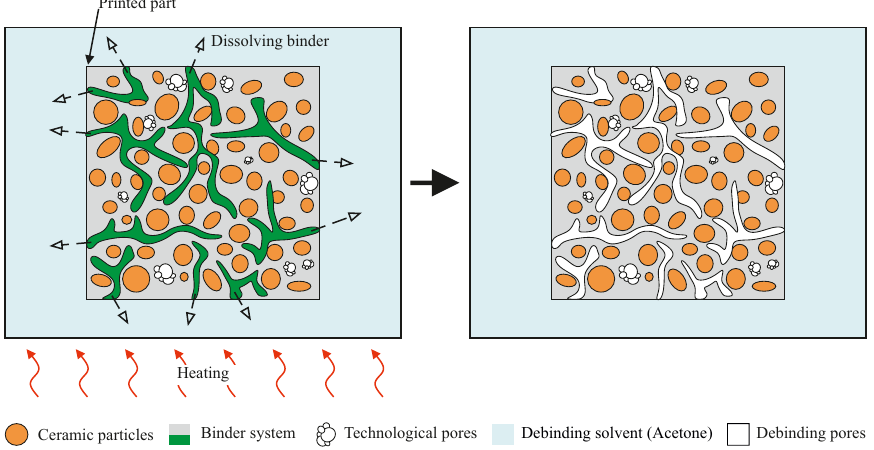
Figure 5. Illustration of solvent debinding process.